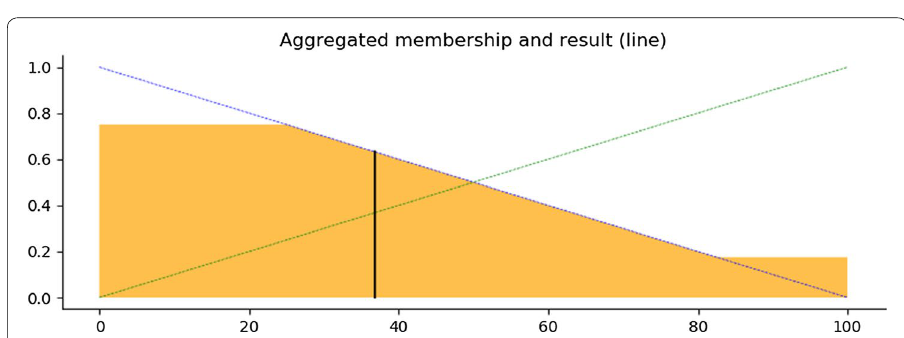
Fig. 4 Aggregated output membership with defuzzified